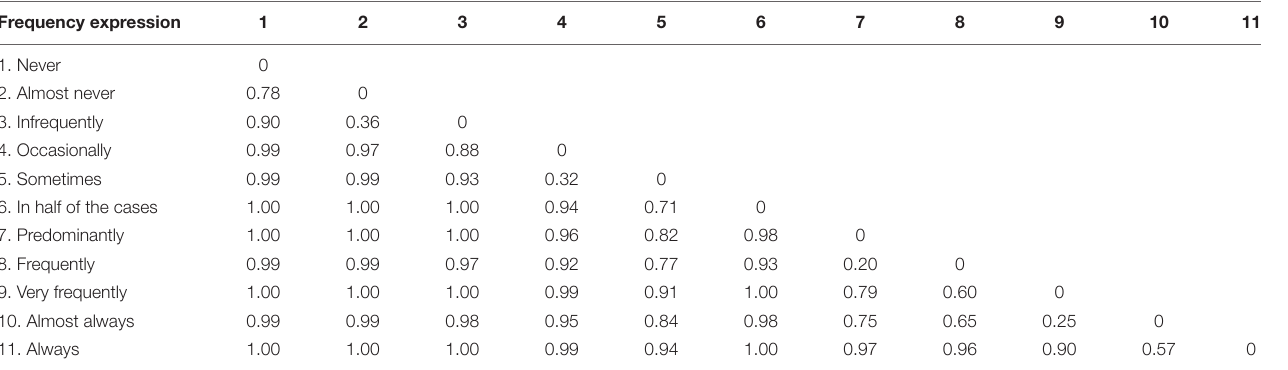
TABLE 1 | Discriminatory power values of membership functions (MFs) of frequency expressions. Frequency